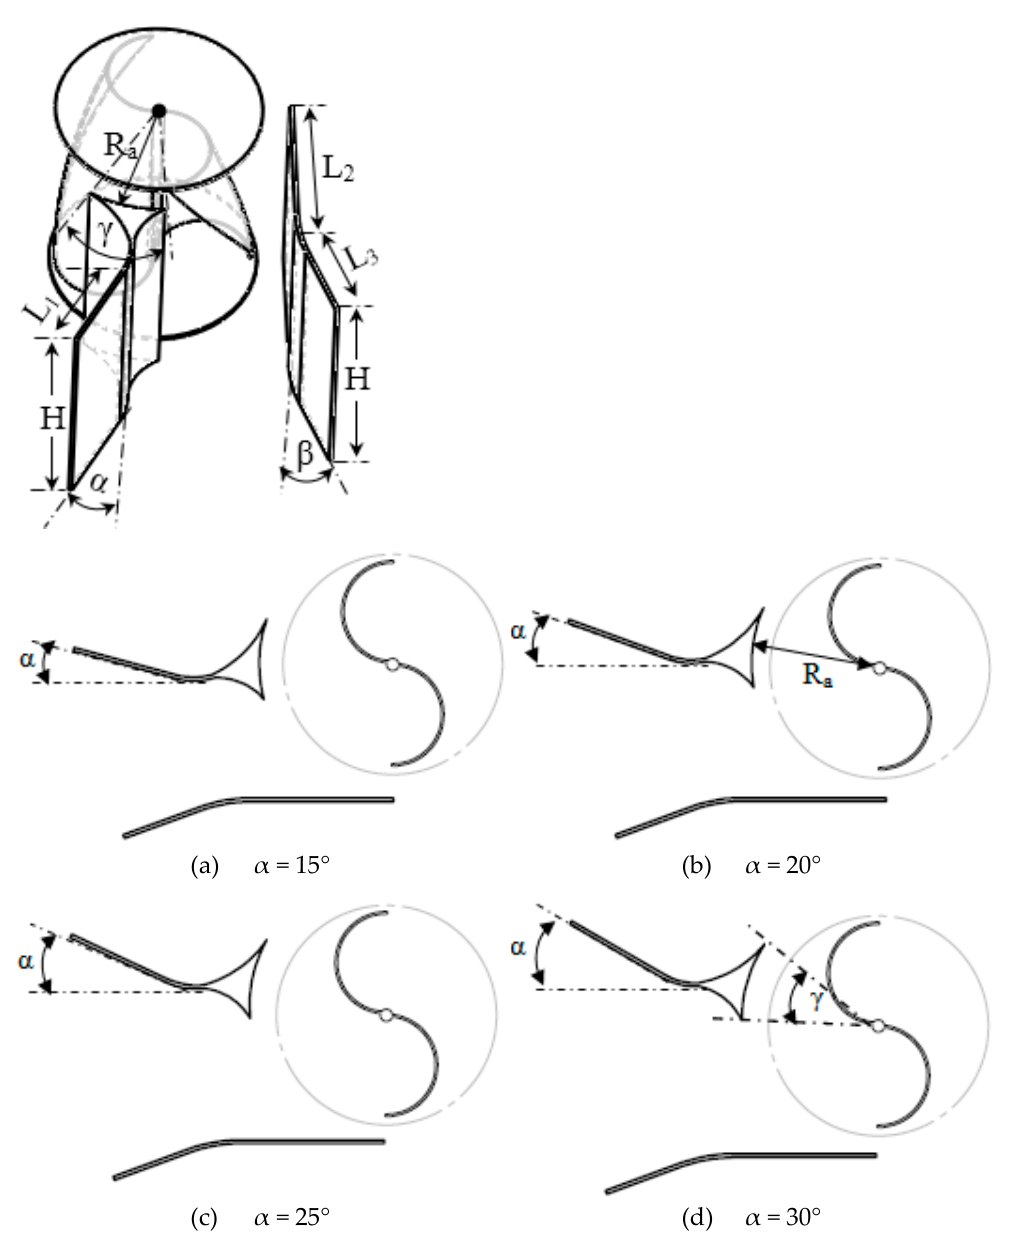
Figure 7. Two-dimensional models of the deflector system with different deflection angles. Table 2. Geometrical parameters of the deflector